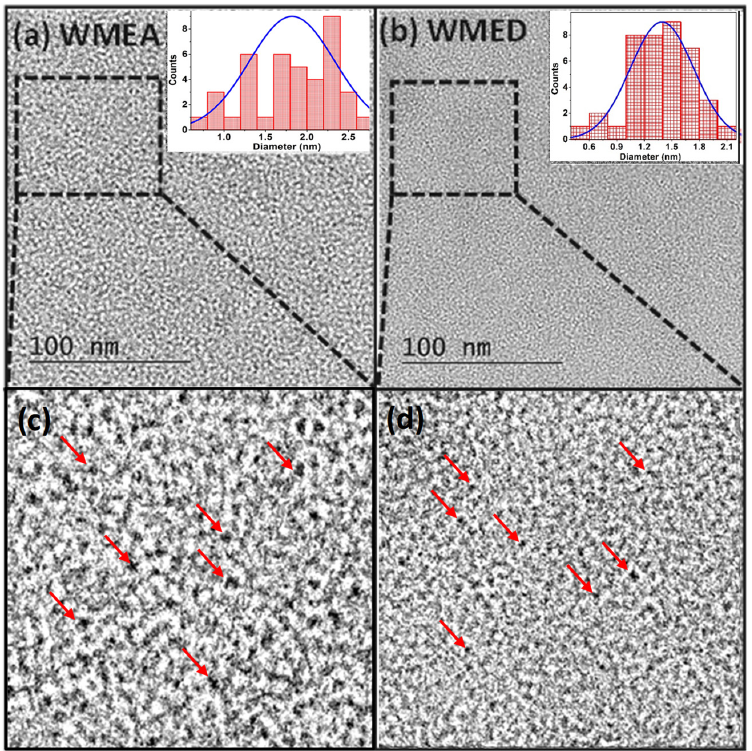
3644 cm − 1 and 3536 cm − 1 for N-H stretching of amine, 2927 cm − 1 for C-H stretching, 2362 cm − 1 for O=C-O stretching, 1646 cm − 1 for C=O stretching of amide, 1425 cm − 1 for aromatic Figure 3. TEM images of watermelon-CQDs ( a ) WMEA CQDs dispersed in water; inset shows par- C=C stretching, 1392 cm − 1 for C-H bending vibrations. FTIR and XPS studies indicated that Figure 3. TEM images of watermelon-CQDs ( a ) WMEA CQDs dispersed in water; inset shows particle ticle size distribution and ( b ) WMED CQDs dispersed in water; inset shows particle size distribu- watermelon-CQDs are functionalized with hydroxyl, carbonyl, carboxylic acid, and am- size distribution and ( b ) WMED CQDs dispersed in water; inset shows particle size distribution; tion; ( c , d ) zoomed TEM images of CQDs, red arrows showed CQDs. ide groups. ( c , d ) zoomed TEM images of CQDs, red arrows showed CQDs.